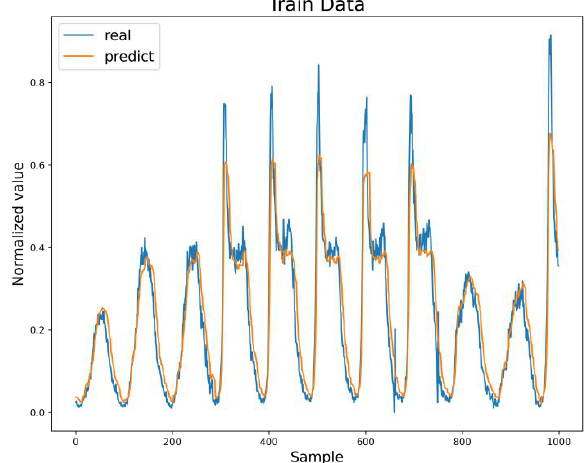
Figure 10. AT-ConvLSTM training results.